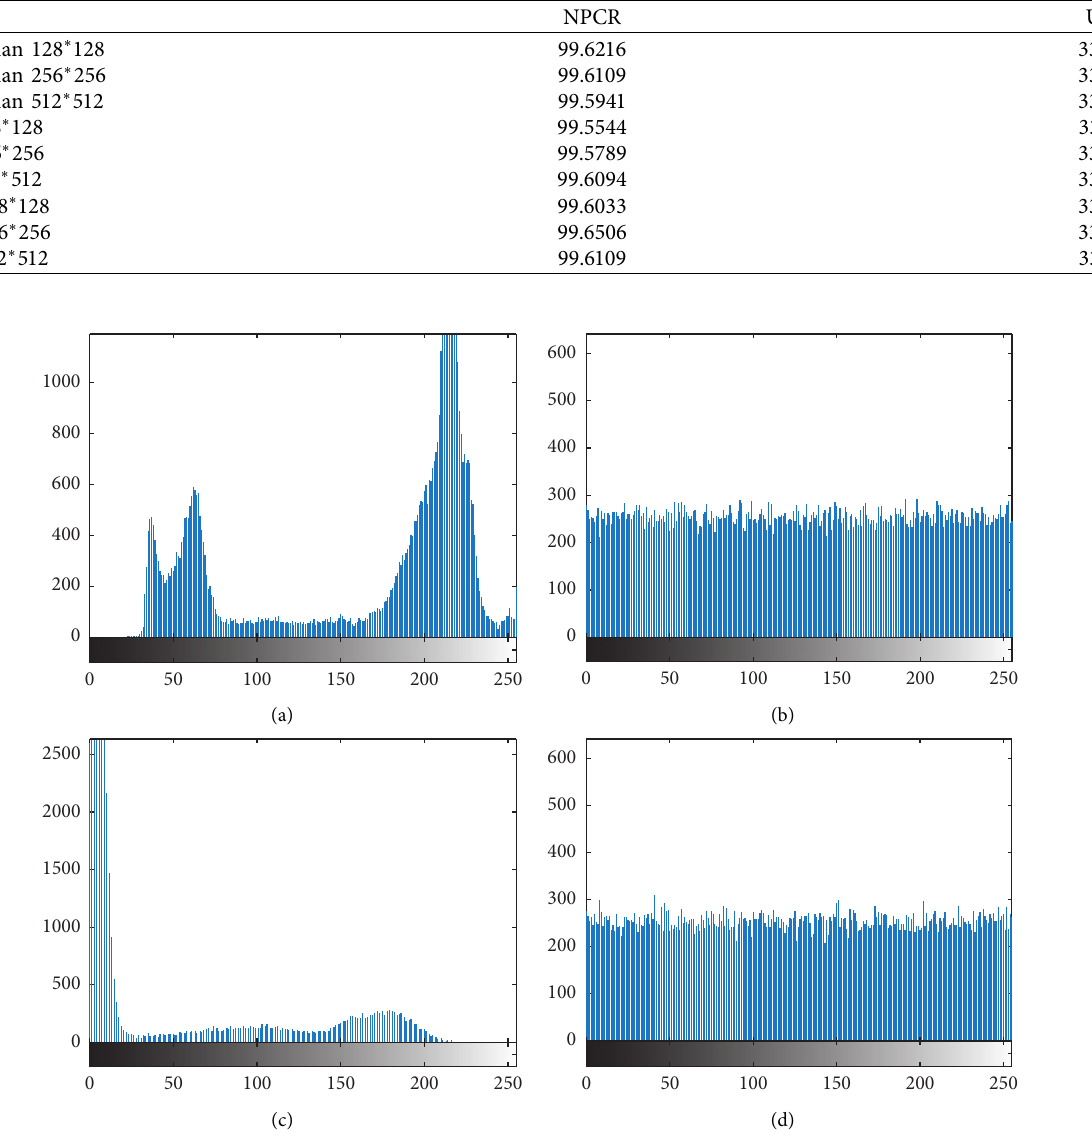
Table 4: The NPCRs and UACIs for differential attack analysis.